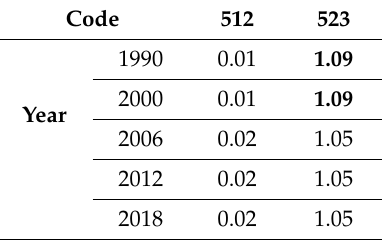
The highest values found are in